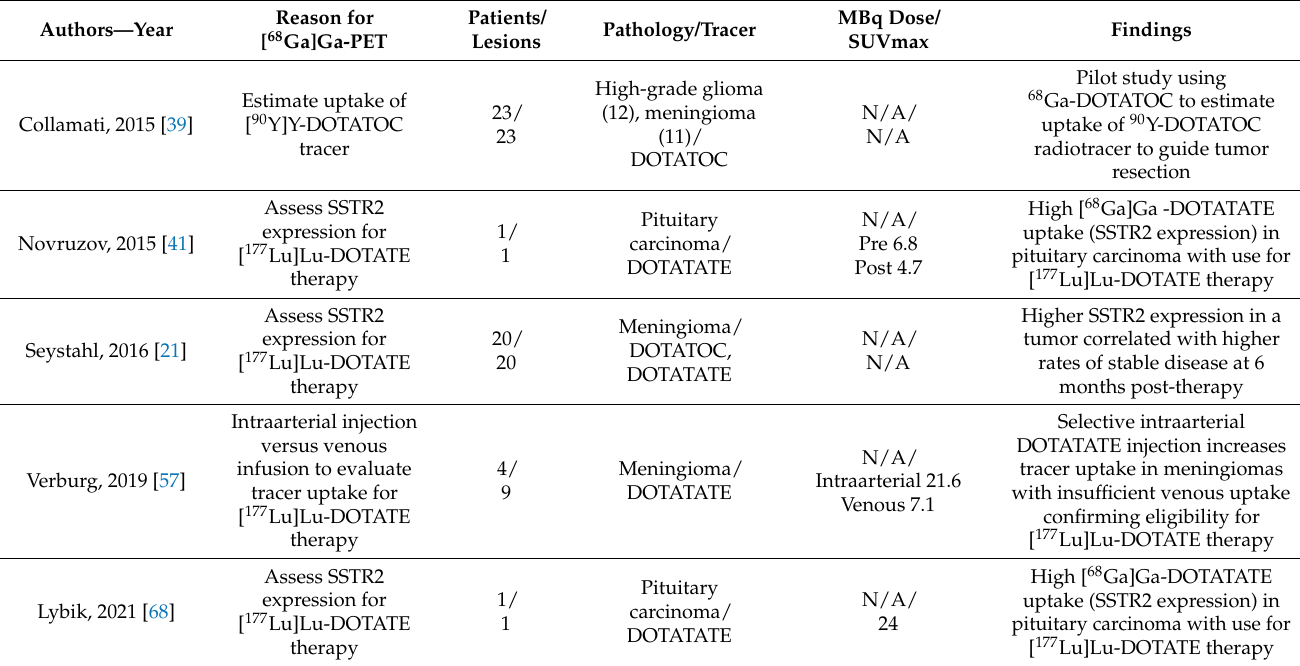
Table 4. Overview of all included studies using [ 68 Ga]Ga-DOTA PET for planning neurotheranostics therapy.